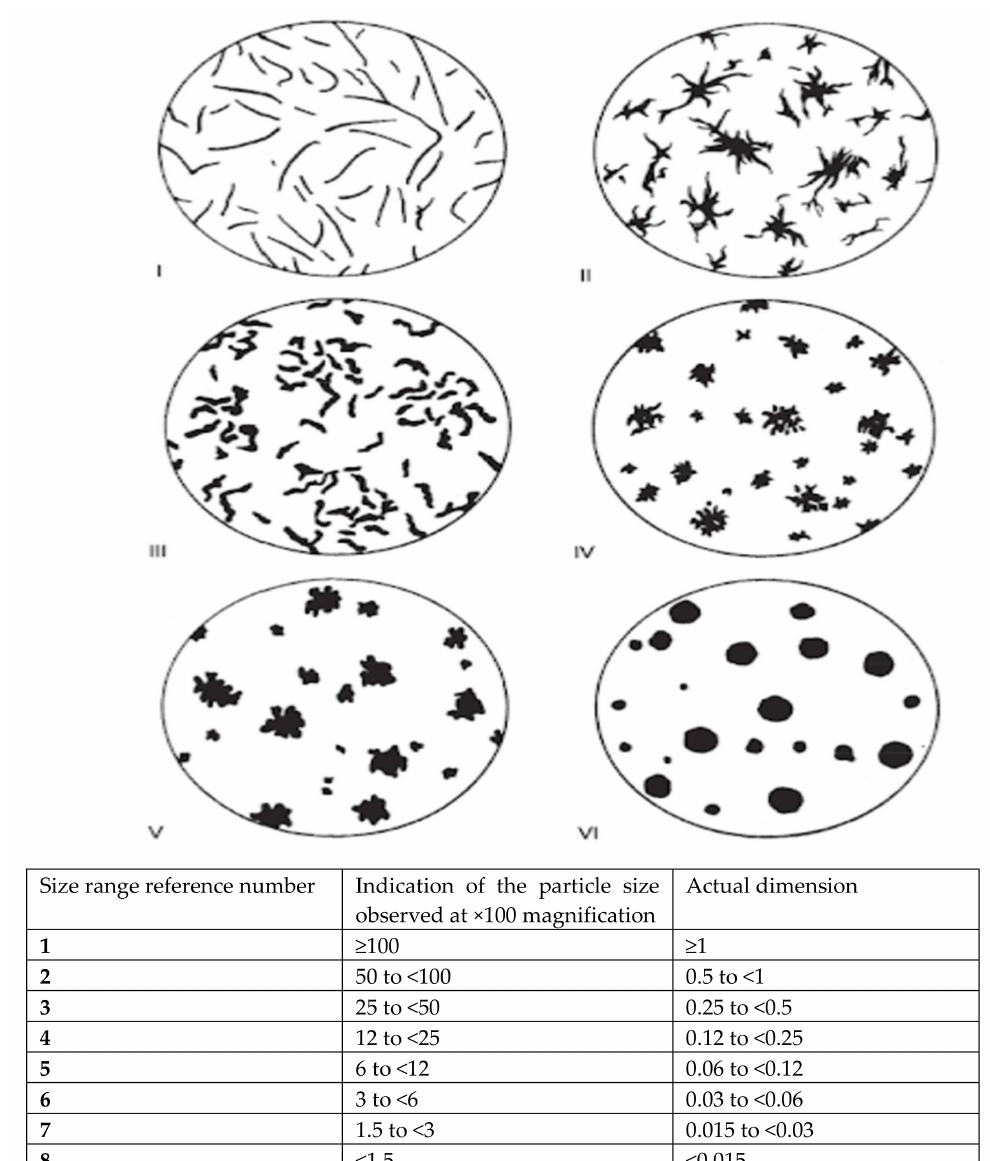
Figure 2. Reference images for the main graphite forms in cast iron. Source: [12]. Dimensions of graphite particle forms I to VI